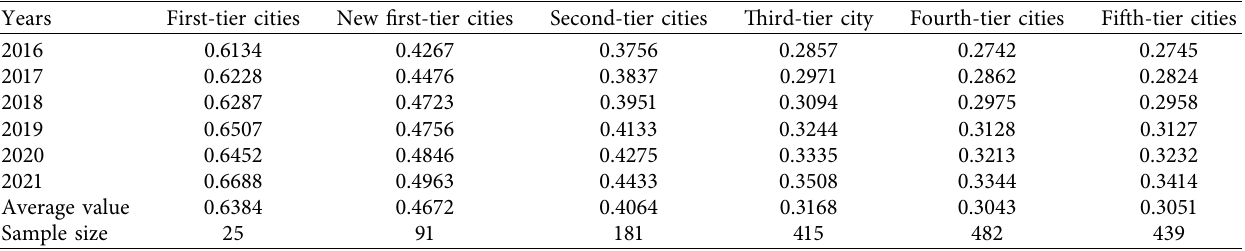
Table 6: Coupling and coordination degree of digital economy and high-quality development in cities of different